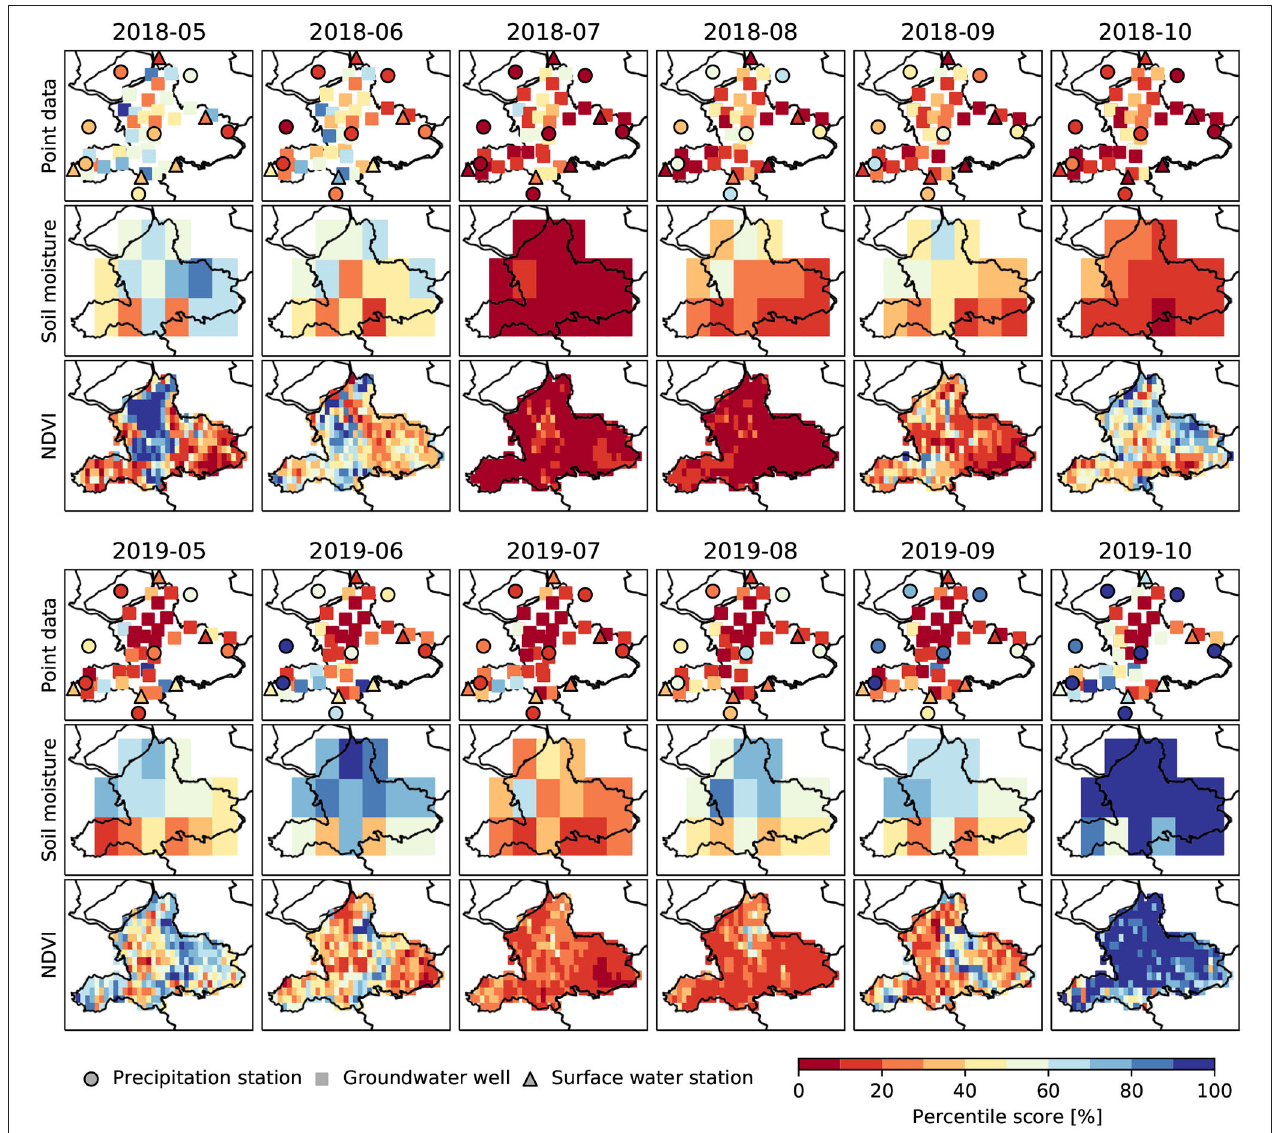
FIGURE 4 | Spatio-temporal evolution of the drought during May-October in 2018 and